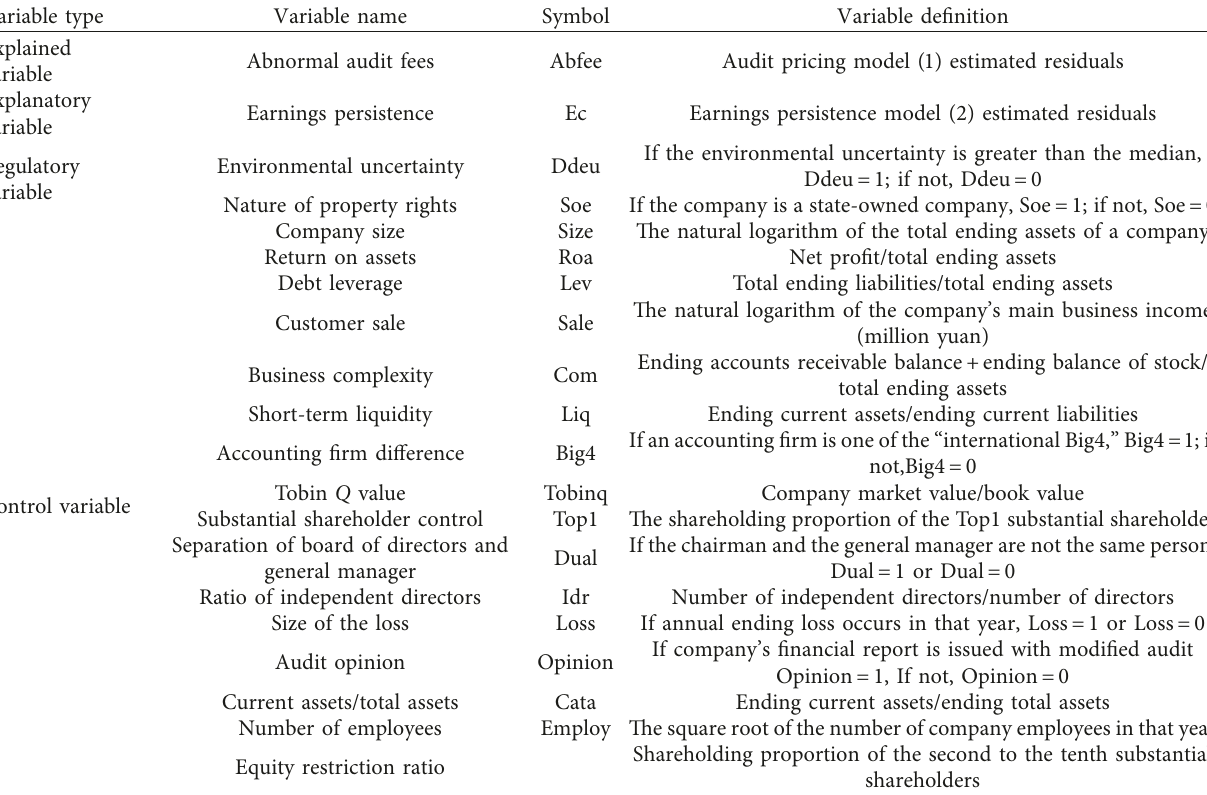
Table 1: Names, symbols, and definitions of related